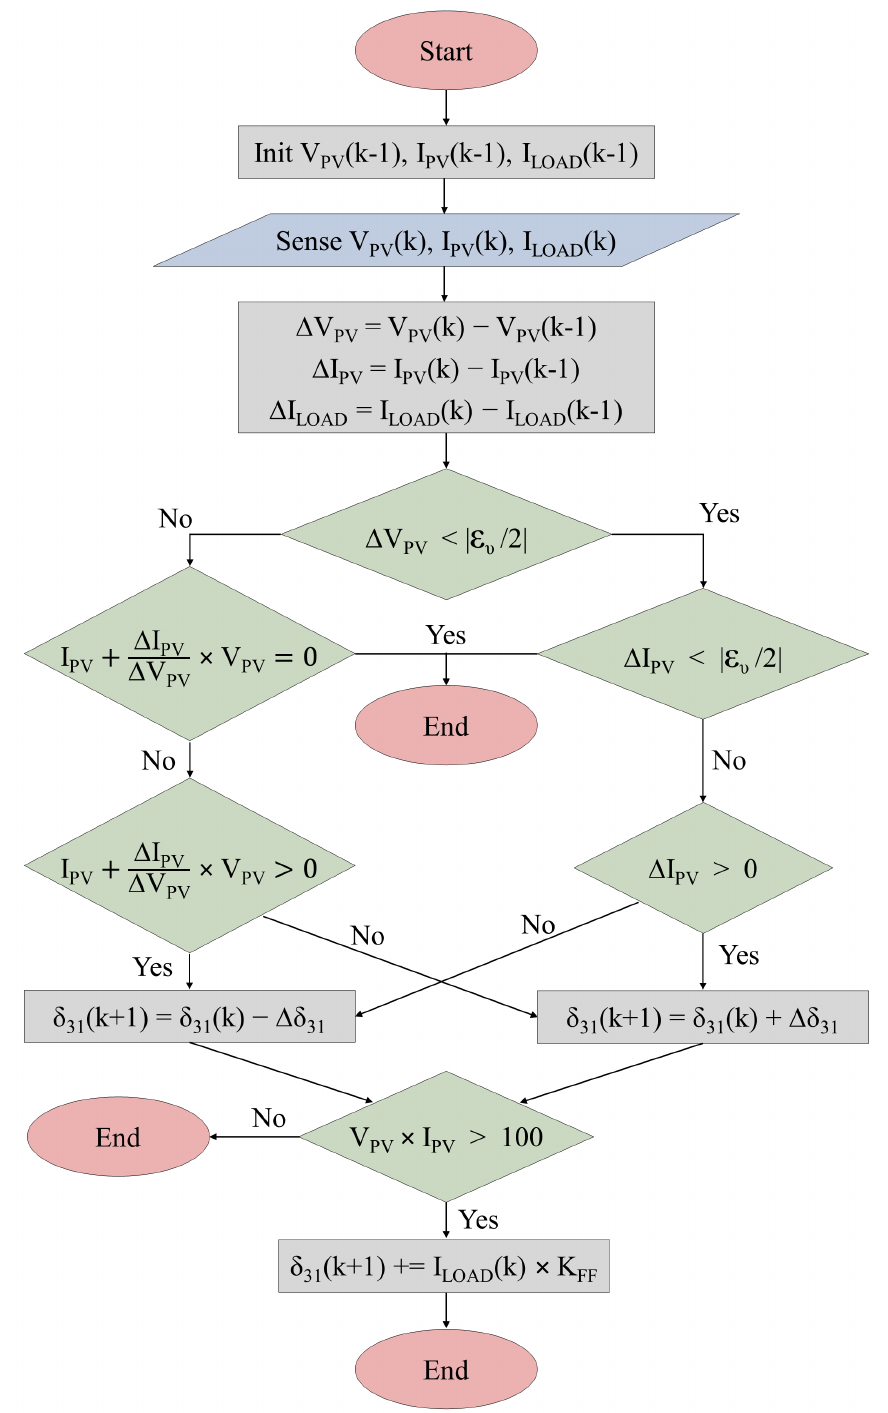
Figure 12. One control cycle MPPT algorithm flow